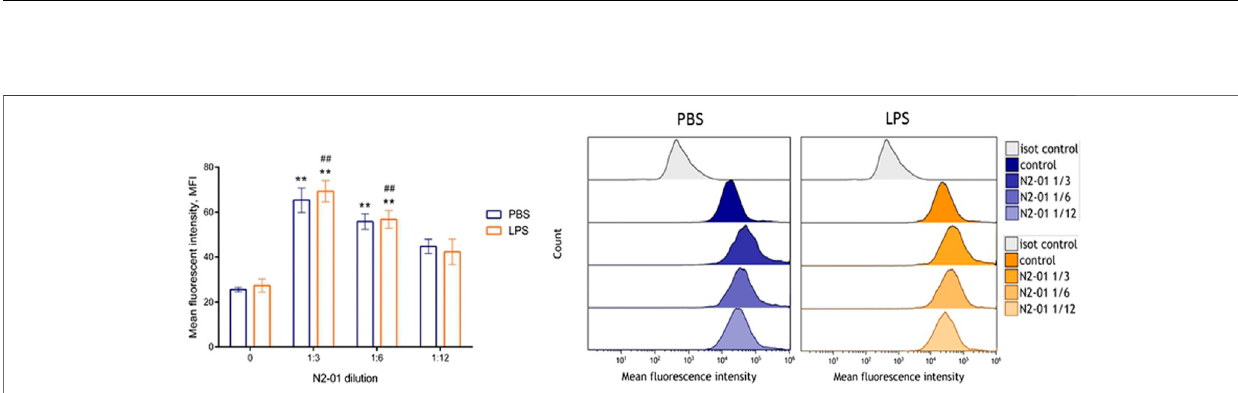
Frontiers in Pharmacology |